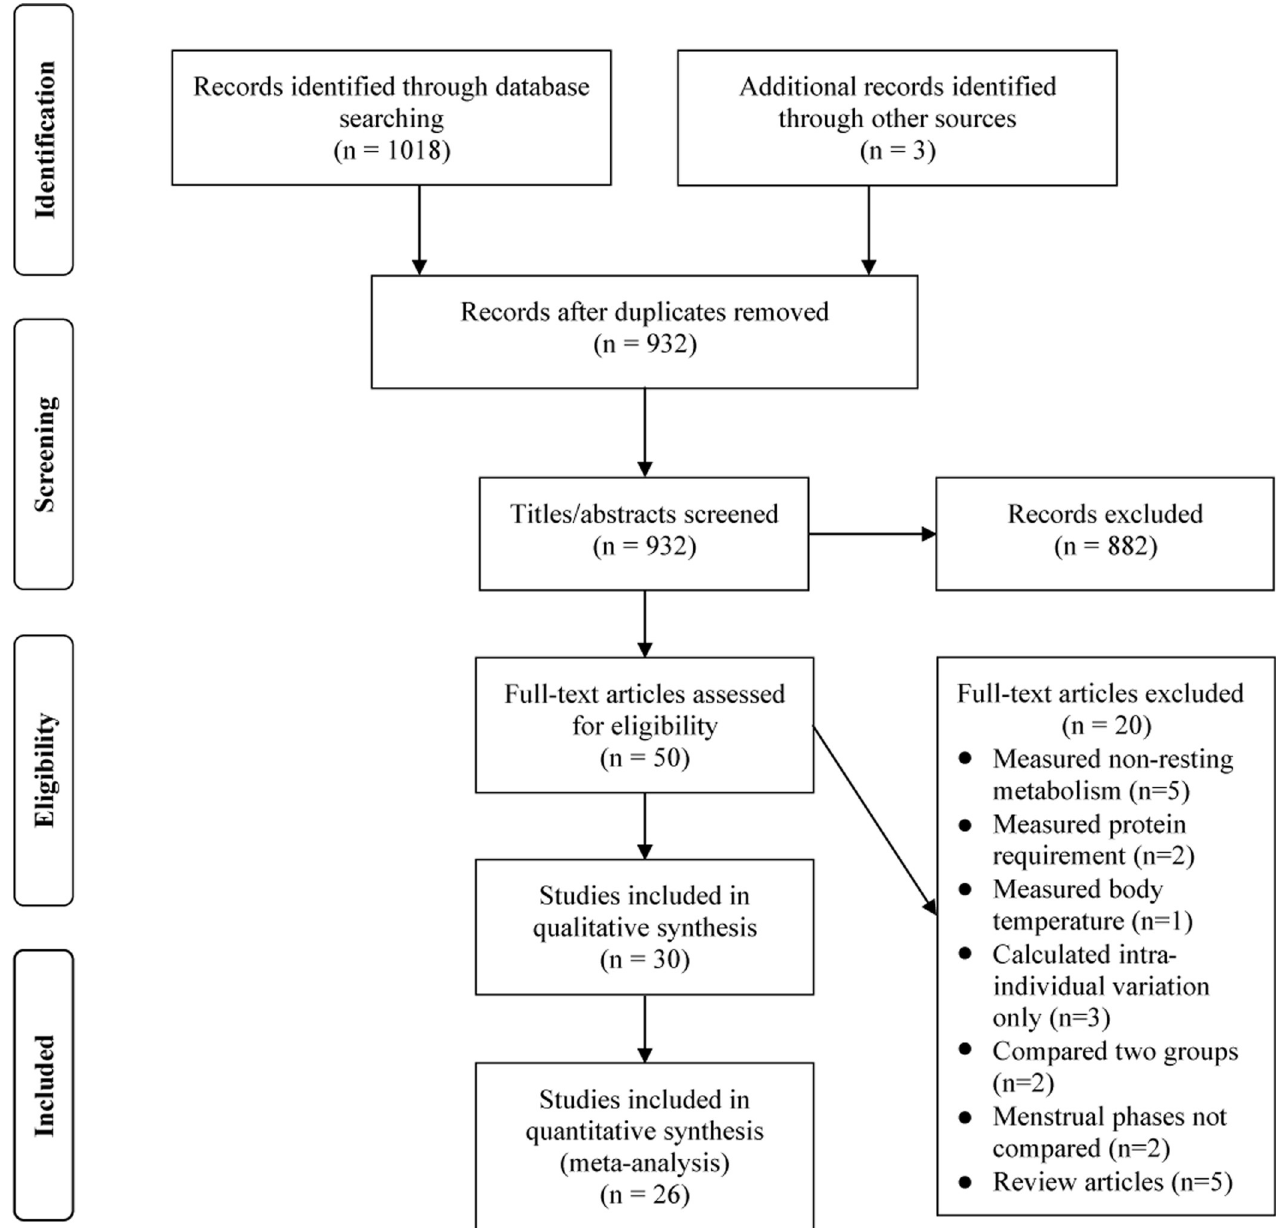
Fig 1. Flow diagram of selection process based on PRISMA